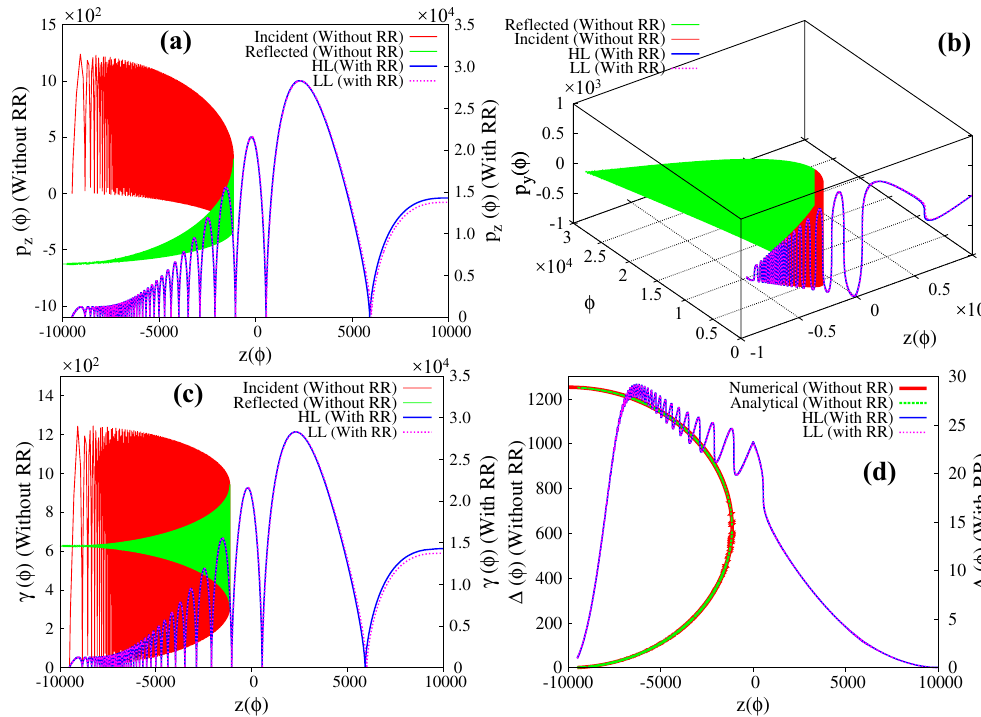
Figure 3. ( a )–( d ) Respectively represent the evolution of longitudinal and transverse momentum, the energy 0 ), intense, focused and the parameter (cid:31) , for a charged particle interacting with a linearly polarized ( δ = electromagnetic wave, in the absence/presence of radiation reaction effects. The intensity at the focal point is 8 . The initial conditions are z 0 9500 , 0 , 1000 ( 1.8 10 10 24 W / cm 2 ) and τ 0 p chosen as a 0 − � = ≈ × = − = ∼ 0 and a ( z 0 ) 885.3 < a 0 ; see text). The 50 , which satisfy the inequality given by Eq. (16) ( a P 0 z ref = = = ⊥ red and green curves in ( a )–( c ) respectively represent the forward and reflected motion of the particle in the absence of radiation reaction effects (values correspond to y-axis on the left), and the corresponding value of the parameter (cid:31) is represented in ( d ) where the red and green curve respectively represent the numerical values and the analytical expression for (cid:31) . The blue and magenta curves in the ( a )–( d ) respectively represent the dynamics in the presence of radiation reaction effects (values correspond to y-axis on the right) as governed by Hartemann-Luhmann and Landau-Lifshitz equation of motion. Note that the apparent discrepancy in the initial conditions seen in the above figures for without and with radiation reaction is due to the use of different axes i.e. left y-axis is for without radiation reaction and right y-axis is for with radiation reaction